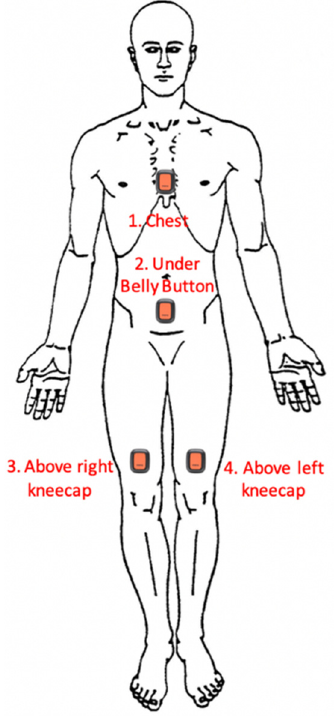
Figure 1. Locations of Xsens DOT Placement on participants.